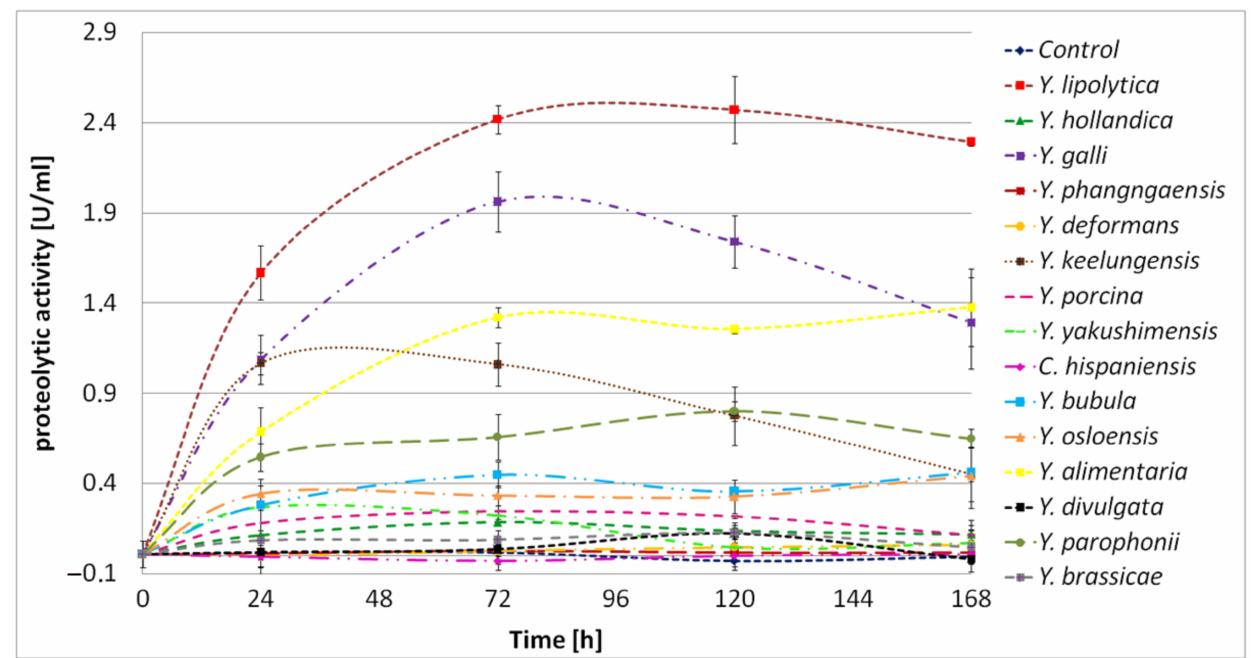
Figure 5. Proteolytic activity of Yarrowia clade species grown in BSG protein medium as a function of time. The results are presented as mean values ± SD. n =